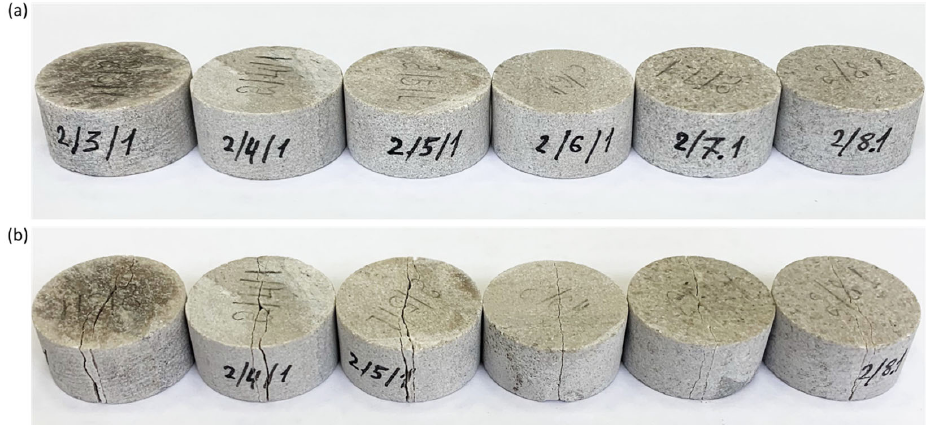
Figure 10. Photographs depicting air ‐ dried limestone samples during indirect determination of the tensile strength throughout the Brazilian test: ( a ) samples before testing; ( b ) samples after testing.